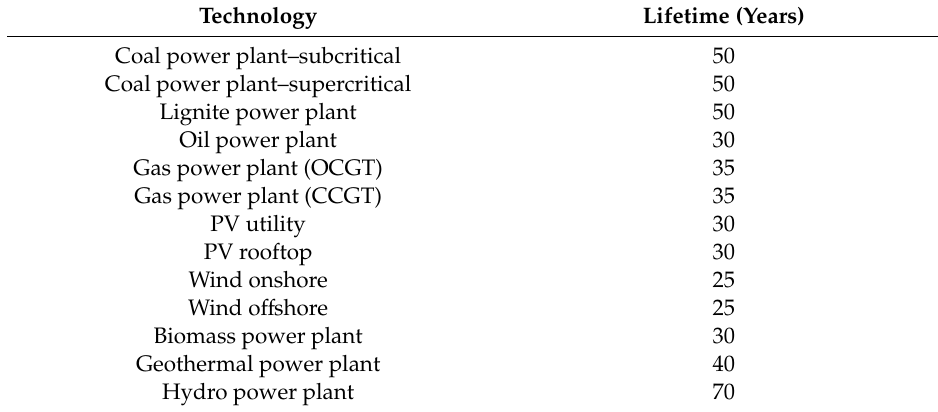
Table A4. Operational lifetime of various power plant technologies. Data based on [18,36,37,39,46].